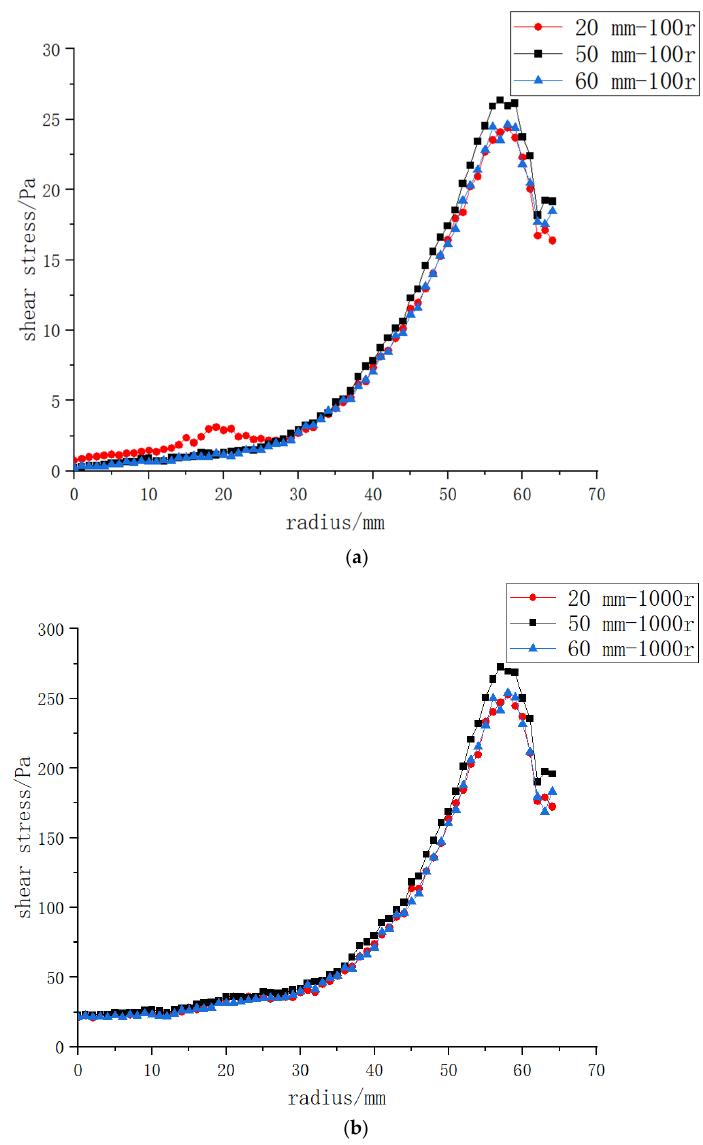
Figure 10. The shear force on the membrane surface when the vane structure is placed at different positions relative to the inlet and outlet, and at different rotating speeds: ( a ): 100 r/min; ( b ): 1000 r/min.